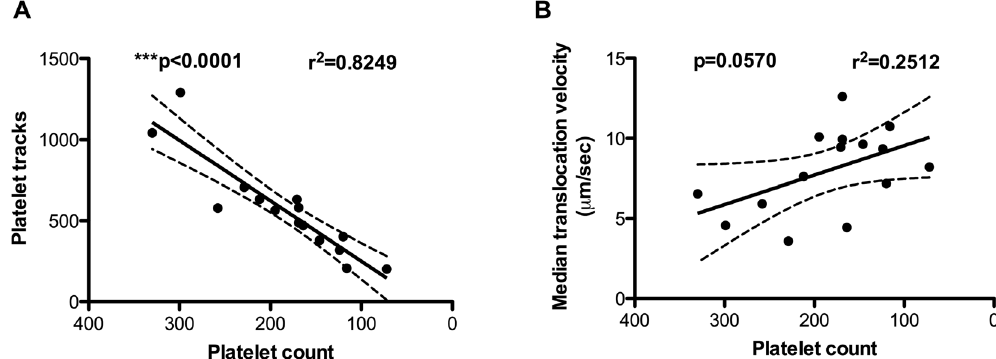
Figure 2. Platelet count has a significant impact on the number of platelets interacting with VWF but not on the translocation speeds. Platelets isolated from whole blood of 5 healthy control donors were diluted in platelet-poor plasma and reconstituted back into RBCs. A simple linear regression model was used to test the slopes between the platelet count and measured platelet interactions with VWF. The best-fit lines with a 95% confidence band are shown in the graph.